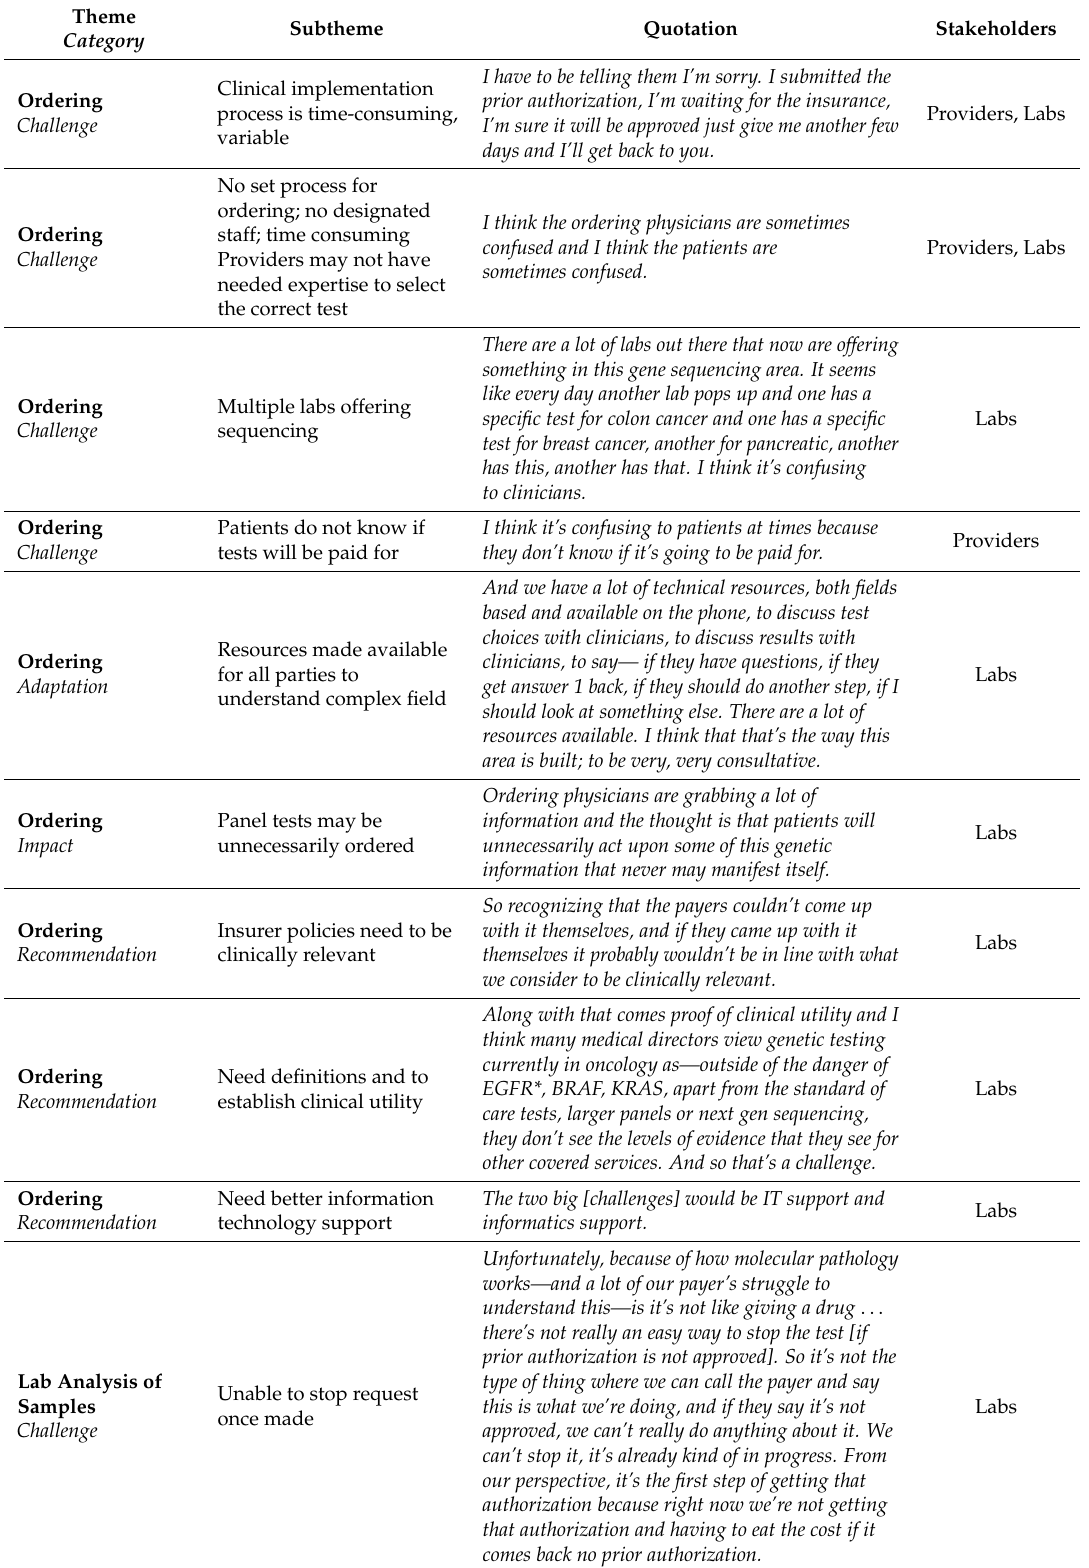
Table 2. Challenges, adaptations, impact, and recommendations on the pharmacogenomic testing